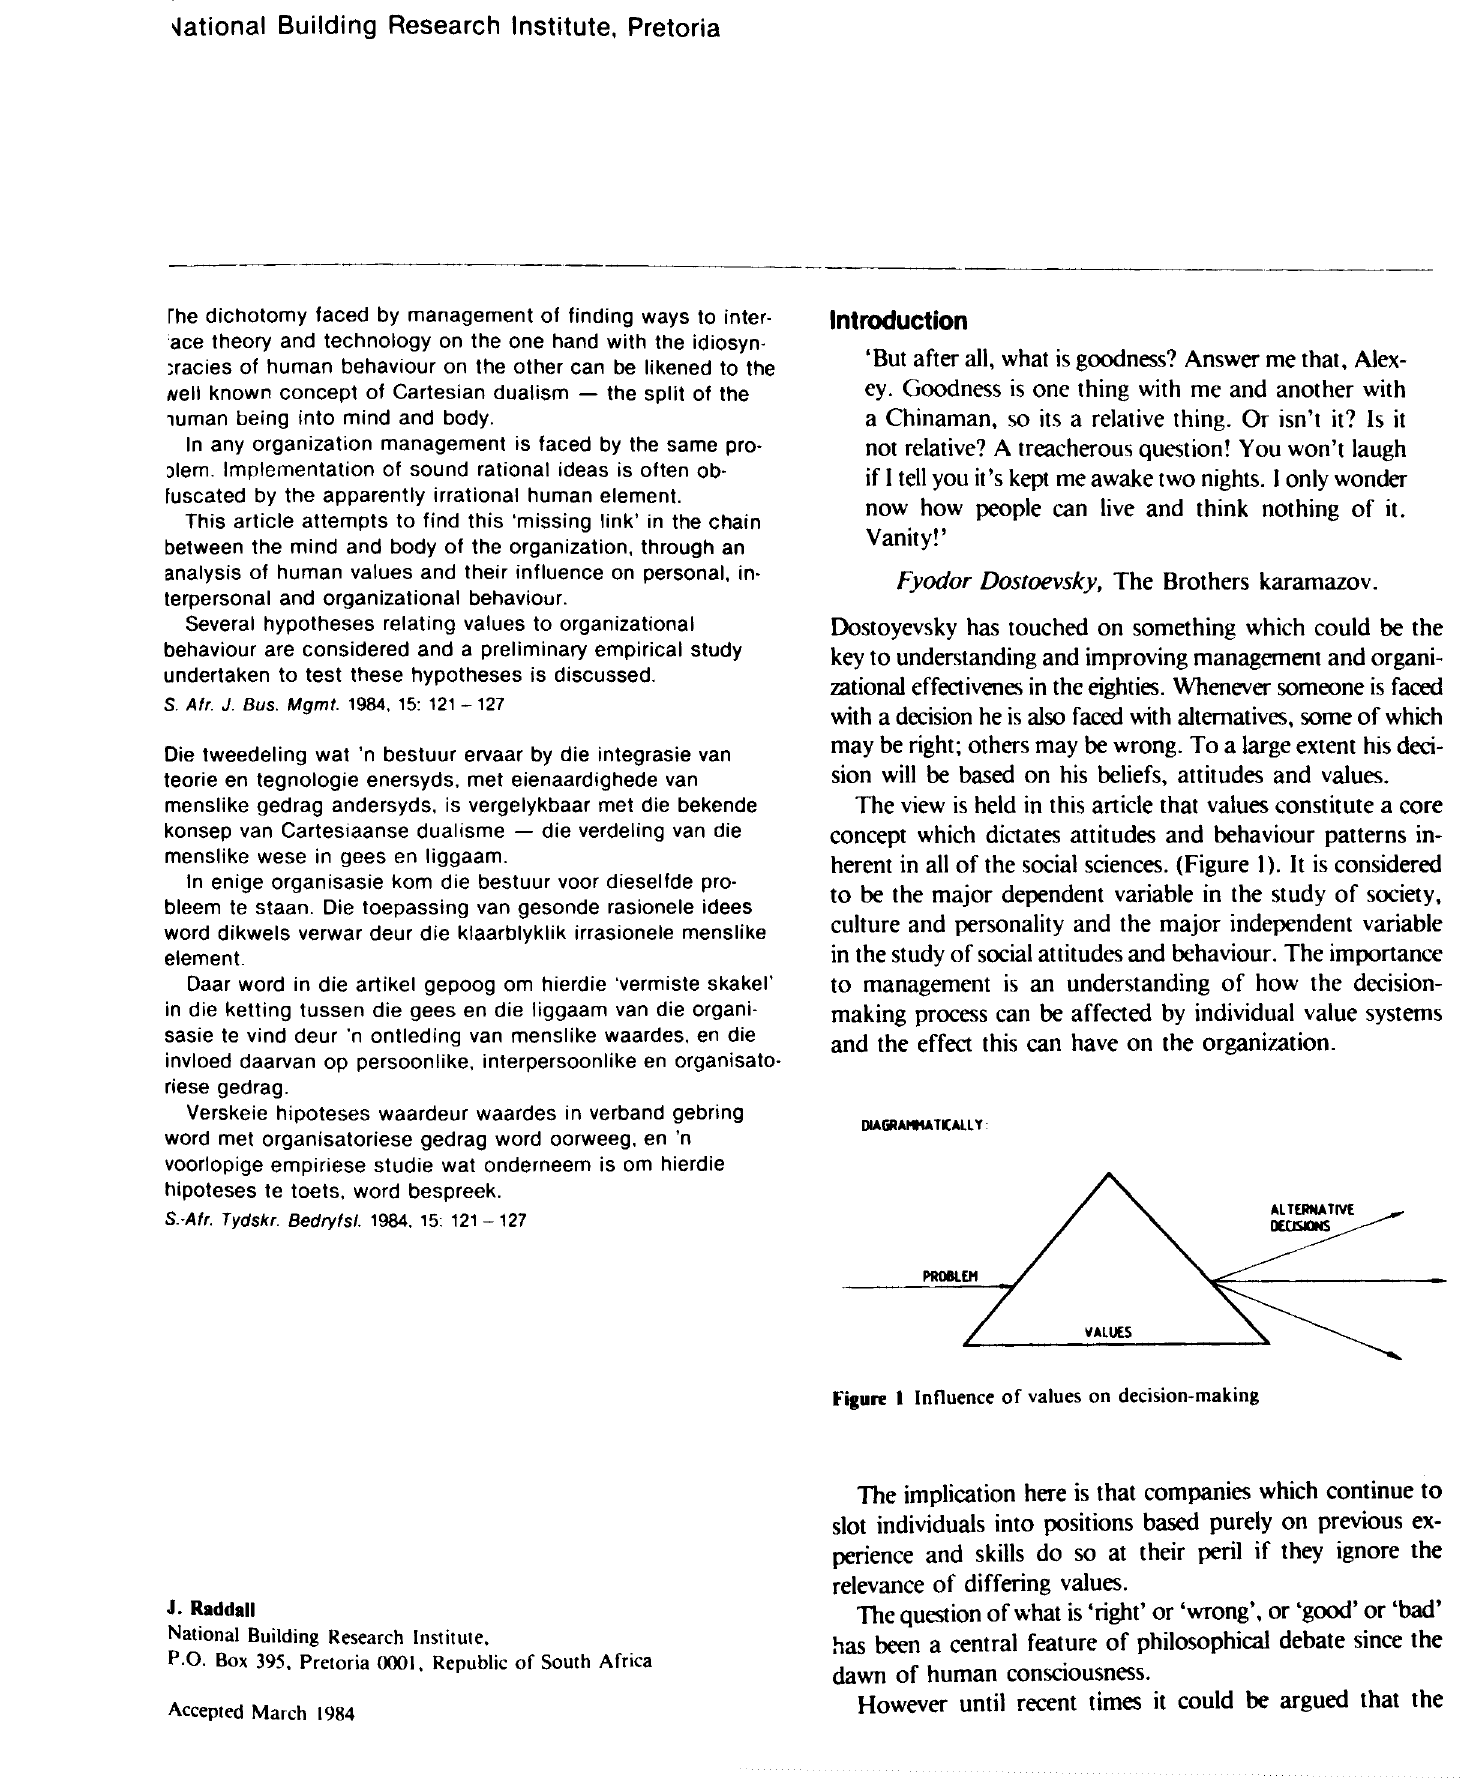
Figure I Influence of values on decision-making